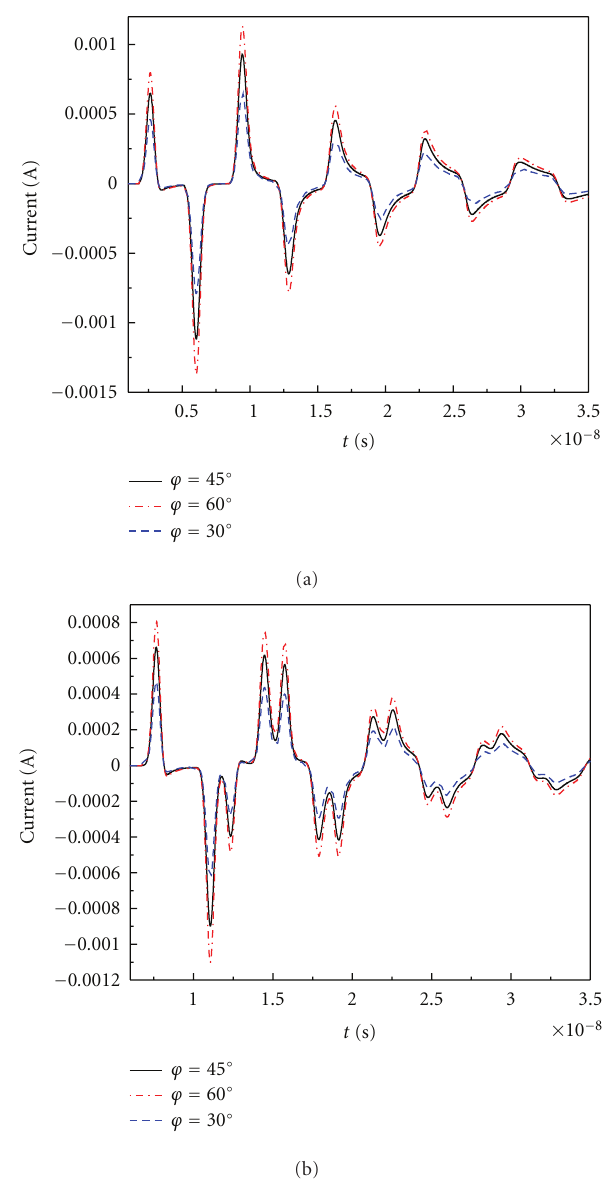
Figure 10: The current induced at midpoint of thin wire with di ff erent incident